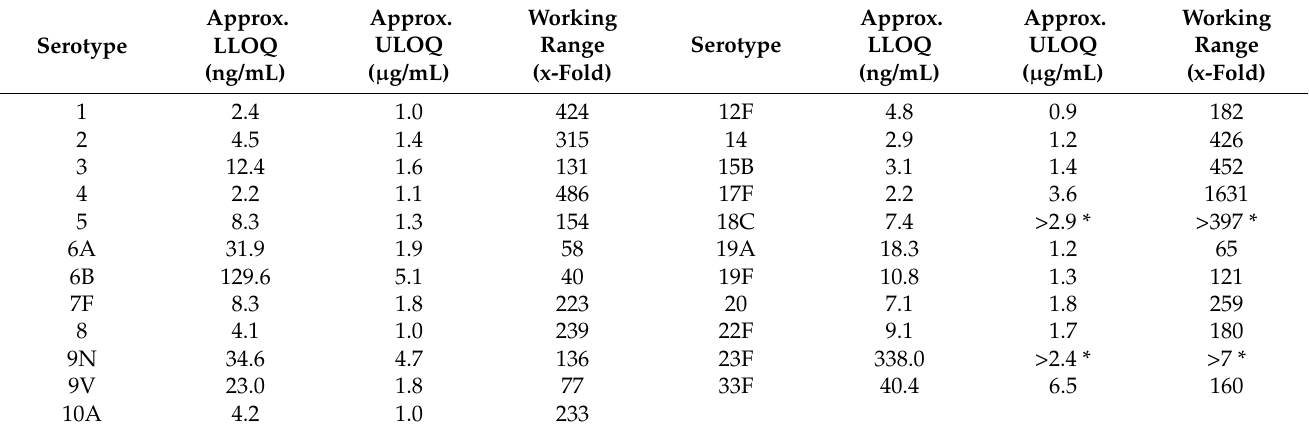
Table 2. Analytical sensitivity and working range for 23-valent Pfizer native PS materials (ATCC, deposited by Pfizer) with 23-Mix Primary Detection